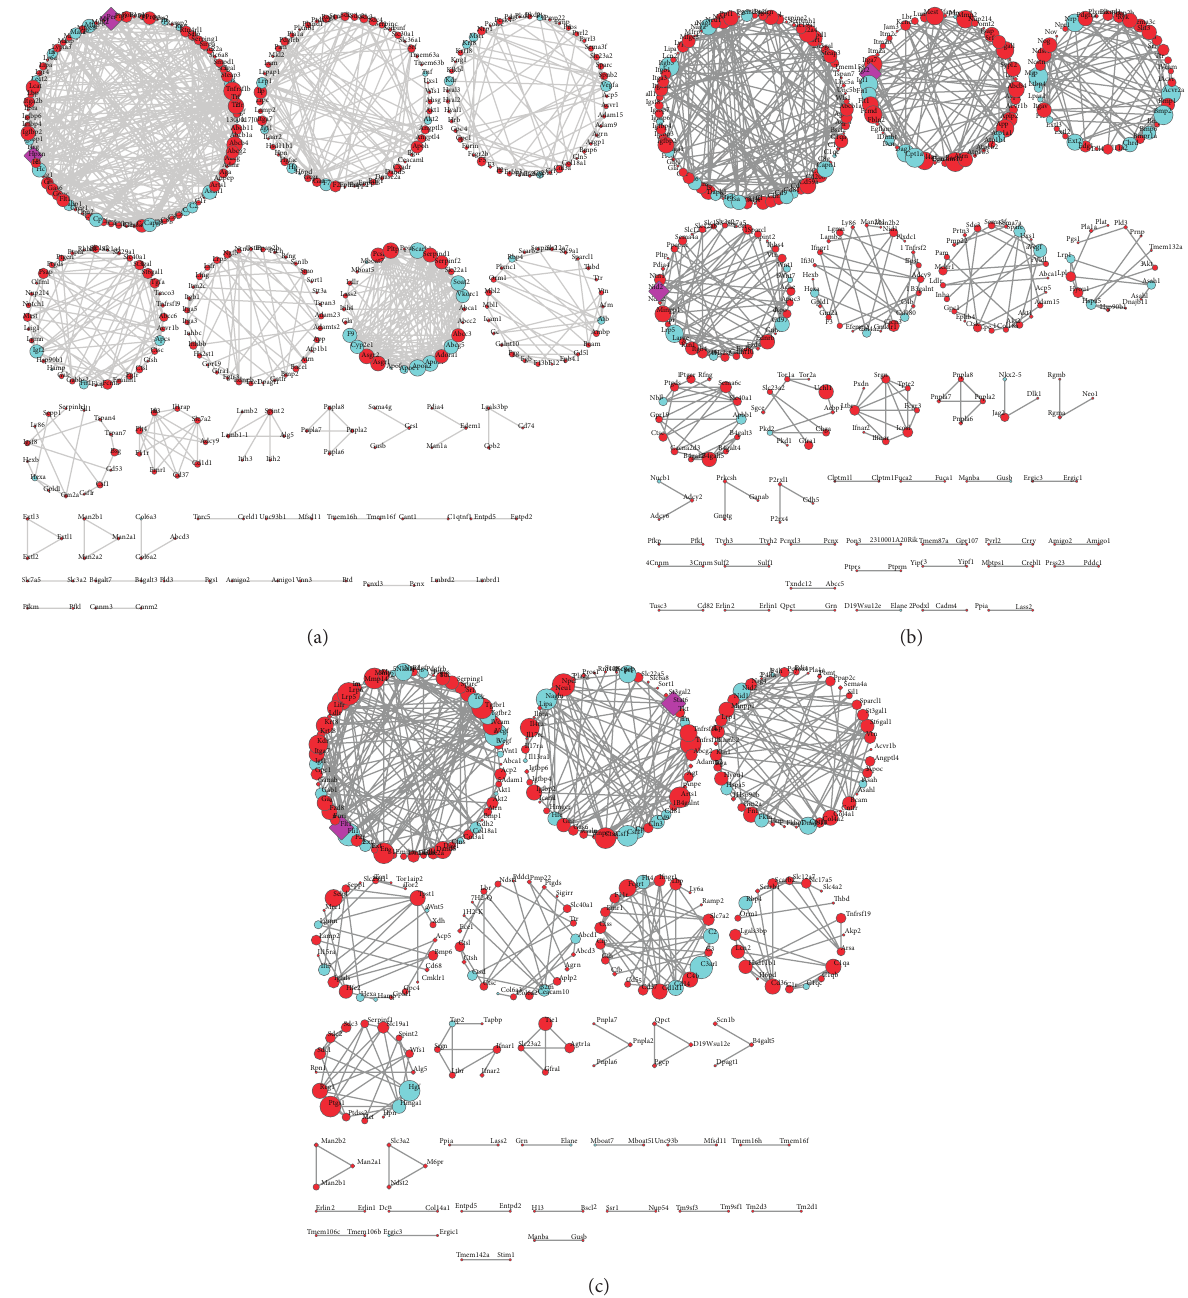
Figure 4: Communities generated by fast greedy (GLay) clustering algorithm are shown. Clusters for (a) BvL579 network, (b) BvM501 network, and (c) LvM442 network are shown. In each community, DEGG nodes are represented by red circles whereas the cyan nodes represent GeneMANIA predicted genes. Hub genes are shown as purple